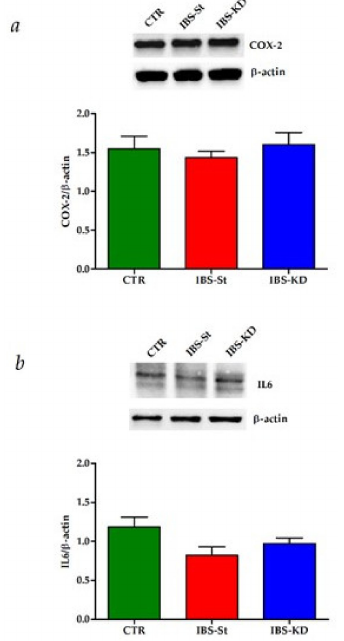
Figure 5. ( a , b ) E-cadherin gene and protein expression levels, respectively, detected in the control group (CTR), IBS rats fed a standard diet (IBS-St), and IBS rats treated with low-carbohydrate, high-fat ketogenic diet (IBS-KD). ( c , d ) Occludin gene and protein expression levels, respectively, detected in the control group (CTR), IBS rats fed a standard diet (IBS-St), IBS rats treated with low-carbohydrate, high-fat ketogenic diet (IBS-KD). ( e , f ) Claudin-1 gene and protein expression levels, respectively, detected in the control group (CTR), IBS rats fed a standard diet (IBS-St), and IBS rats treated with low-carbohydrate, high-fat ketogenic diet (IBS-KD). All data represent the results of three different experiments (mean ± SD). p -value was determined by ANOVA with Tukey’s multiple comparison test * p < 0.05, ** p < 0.01, and *** p < 0.001.